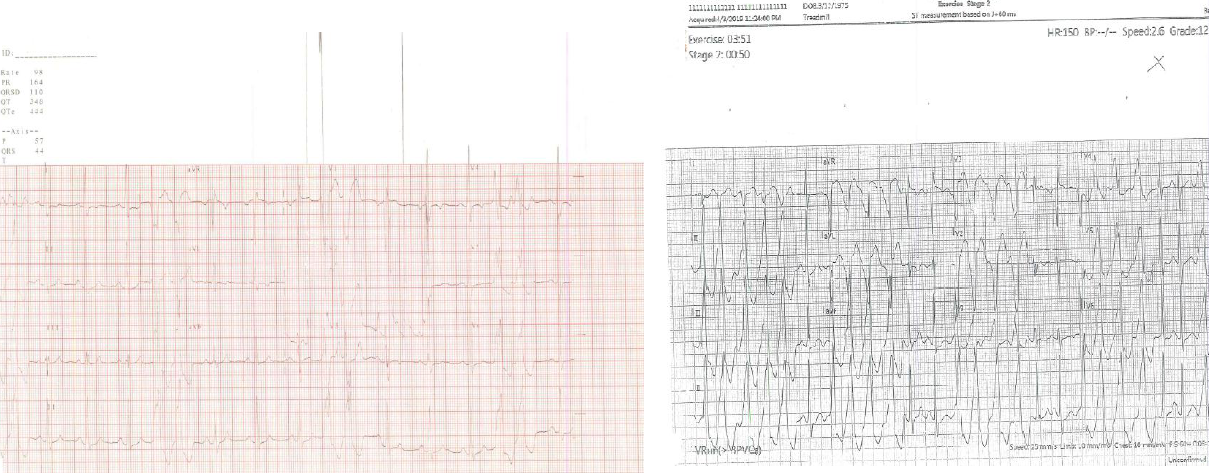
Figure 1: Stress ECG with non-sustained Ventricular tachycardia